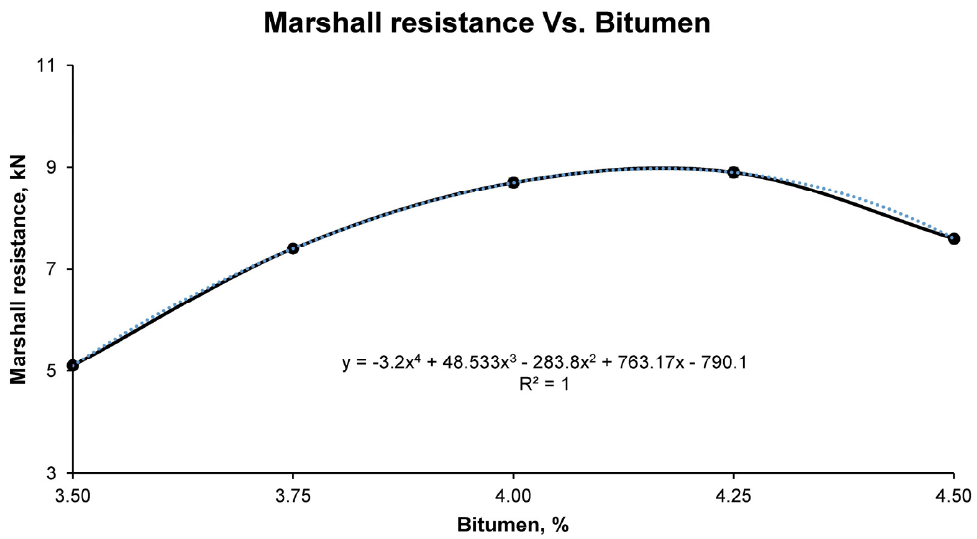
Figure 13. Marshall resistance of bituminous mixtures conforming with leaching residue and increasing percentages of bitumen emulsion.